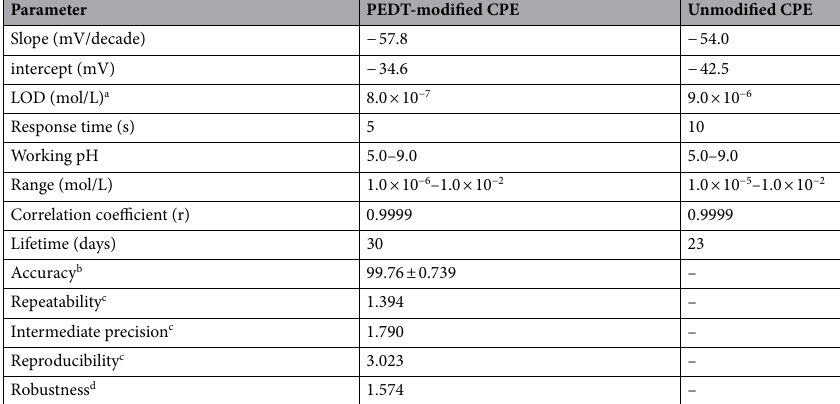
Fig. 4. The potential drift of unmodified CPE is attributed to the replacement of PRO by furosemide leading to alteration in the composition of ions through membrane ions flow 28 . Soaking time effect.